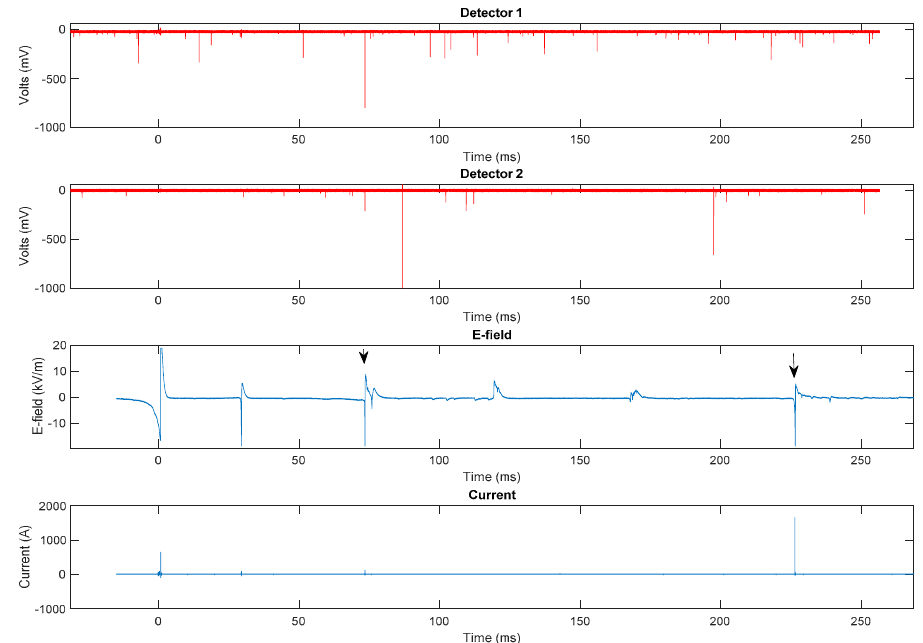
Figure 5. Full X-ray record of the flash containing the strokes shown in Figures 2 and 3. The time t = 0 corresponds to 16:09:36.072213 UTC. X-rays were recorded with a 300-ms time window. The RSs described in Figures 2 and 3 are indicated by the two arrows in the E-field waveform. Two more subsequent RSs occurred later in time are not